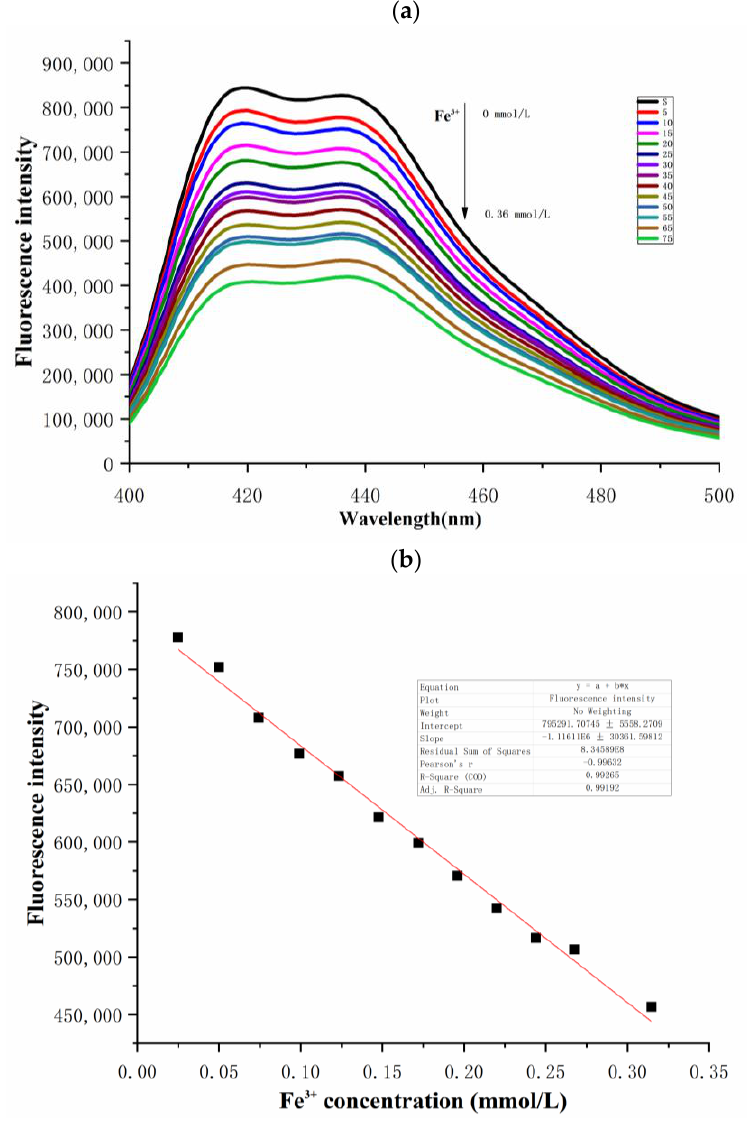
Figure 7. ( a ) Fluorescence response of probe S (20 µ M) to different concentrations of Fe 3+ (0 to 0.35 mM) in acetonitrile–MOPS buffer. ( b ) Linear correlation between the concentrations of Fe 3+ (0 to 0.35 mM) and corresponding fluorescence intensities ( λ ex = 355 nm, λ em : 420 nm, slit: 10 nm/10 nm.).